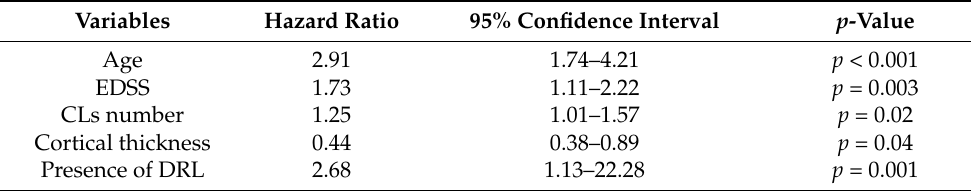
Table 4. Hazard ratios for the development of SPMS after 15